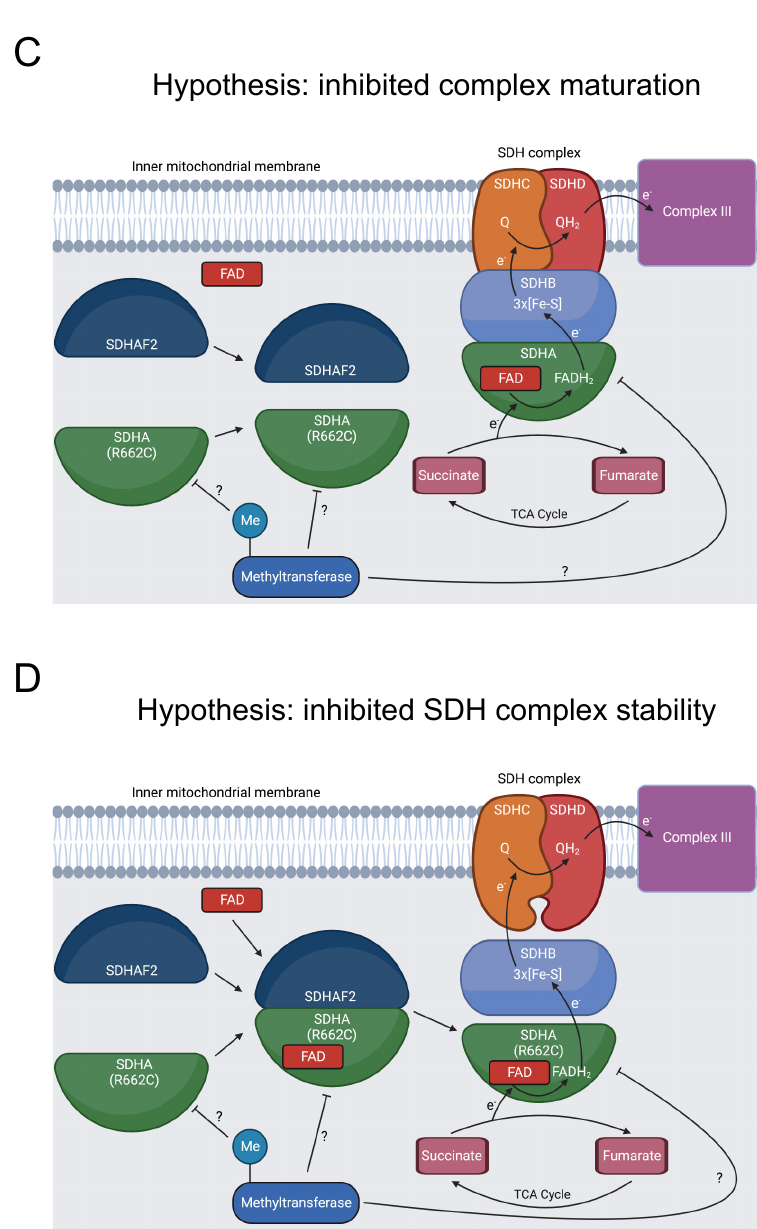
Figure 7. Diagram showing formation of the SDHA-SDHAF2 complex, SDHA methylation, and SDH’s role in oxidative phosphorylation and the TCA cycle. ( A ) SDHA and SDHAF2 form an intermediate complex, which promotes binding of the FAD cofactor to SDHA [136,137]. The full SDH complex then assembles. The heterotetramer operates as complex II in the electron transport chain and oxidizes succinate to fumarate in the TCA cycle [138]. At some point, R662 of SDHA is methylated [31]. This could occur prior to the SDHA-SDHAF2 complex formation, during SDHA-SDHAF2 complex formation, during SDH complex assembly, or after SDH complex assembly, as indicated by the “?” symbol. ( B ) R662C disrupts R662 methylation and precipitates MCIID [23,24,139]. A possible mechanism is disruption of SDHA flavinylation. ( C ) Another possible mechanism is inhibited complex maturation and formation of the SDHA-SDHAF2 complex. ( D ) A final proposed mechanism is increased instability of the full SDH complex.